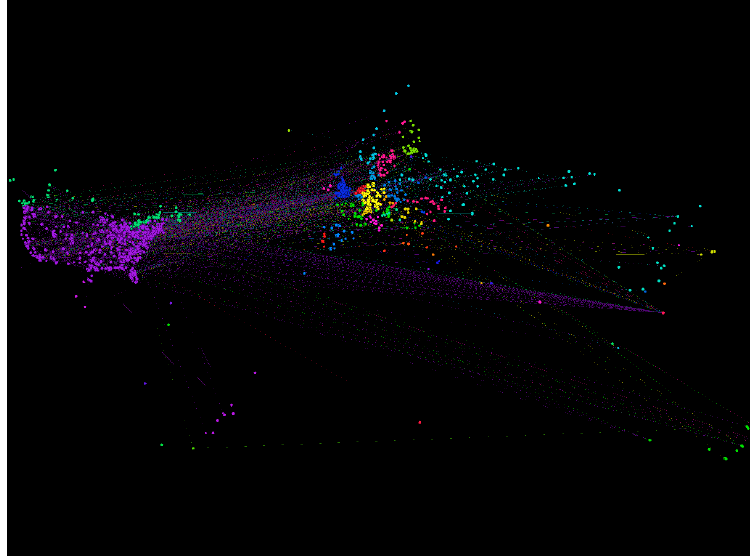
Figure 42. Bitcoin Network and Earth Geography